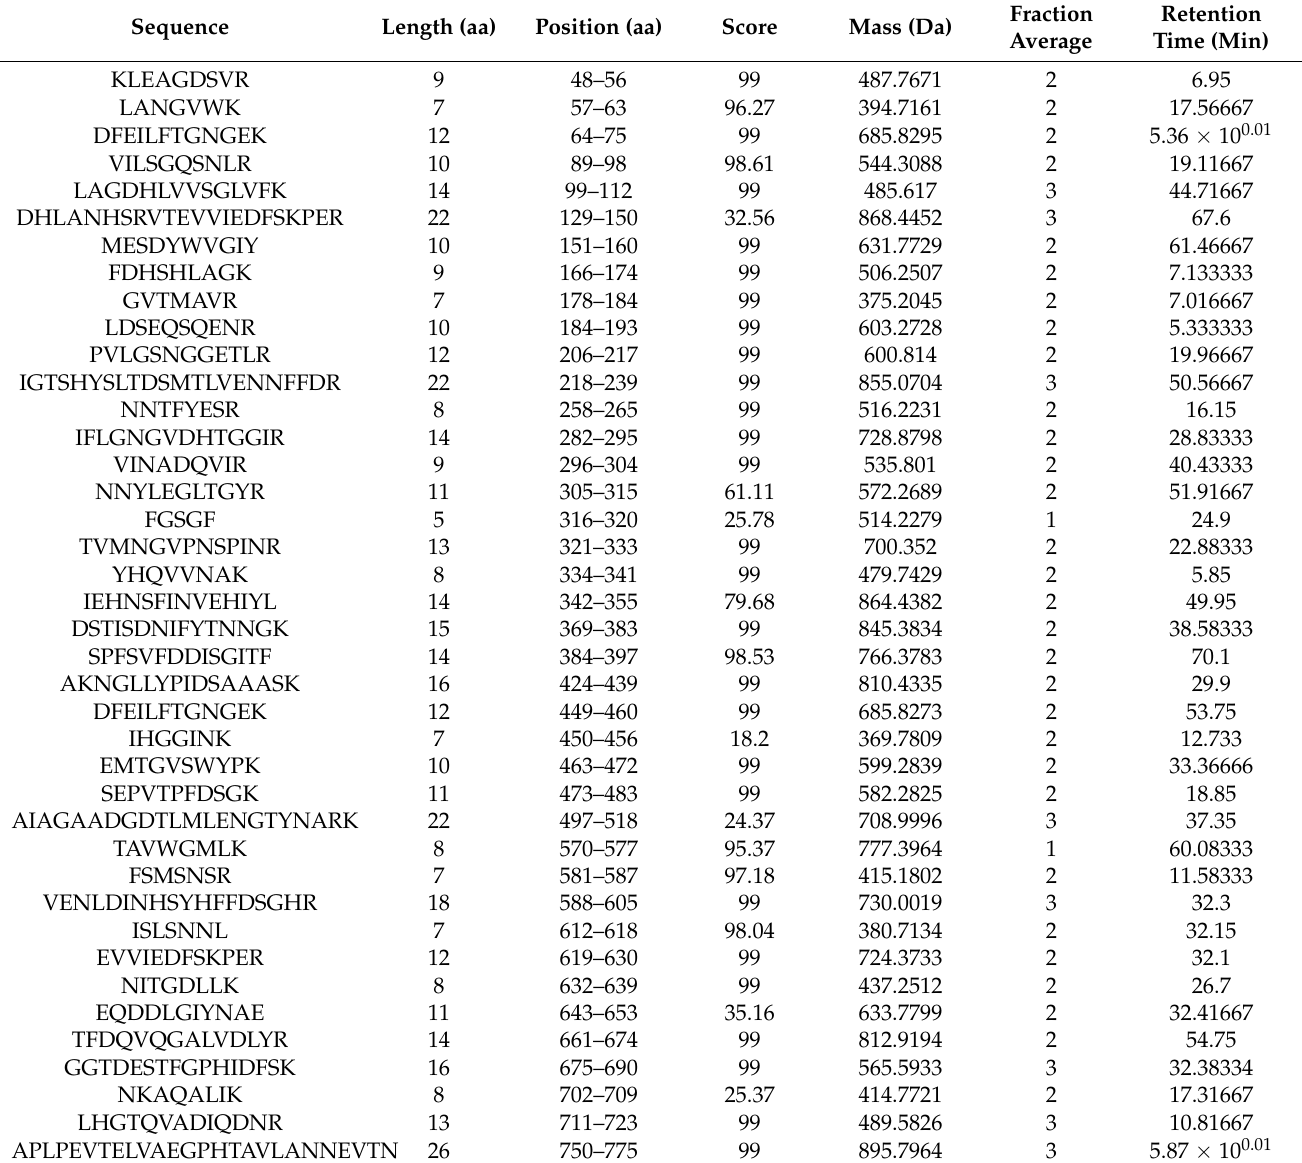
Table 1. Tryptic peptide sequencing of fractionated ChSase B6 by